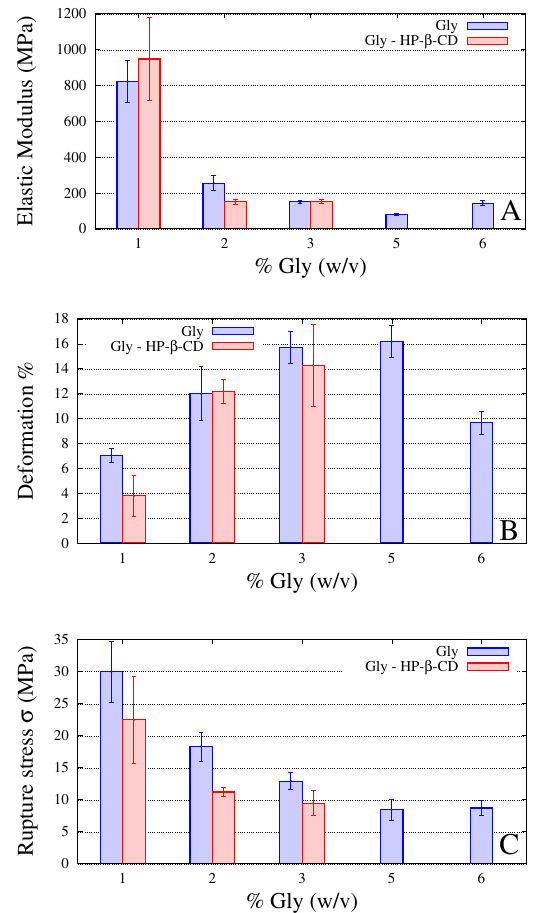
Figure 3. Elastic modulus ( A ), deformation ( B ) and stress ( C ) at break of films for increasing amounts of glycerol, % Gly ( w / v ), with and without HP- β